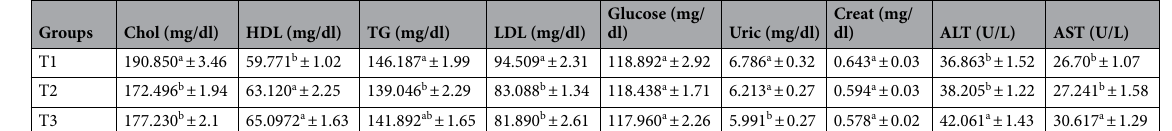
Glucose (mg/ dl) Uric (mg/dl)